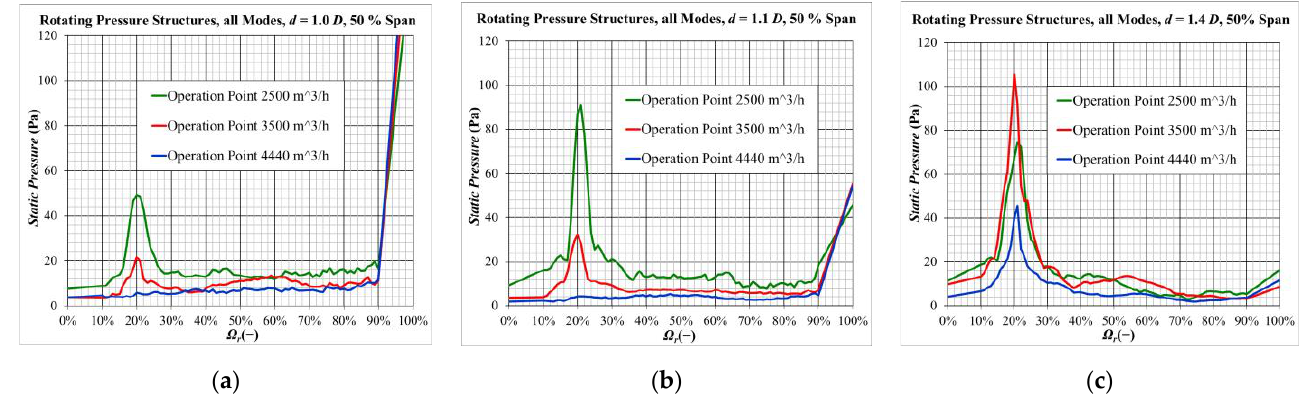
Figure 6. Results of modal analysis of the rotating structures downstream of the fan wheel at Midspan, for radial positions: ( a ) at d = 1.0 D; ( b ) at d = 1.1 D; ( c ) at d = 1.4 D .